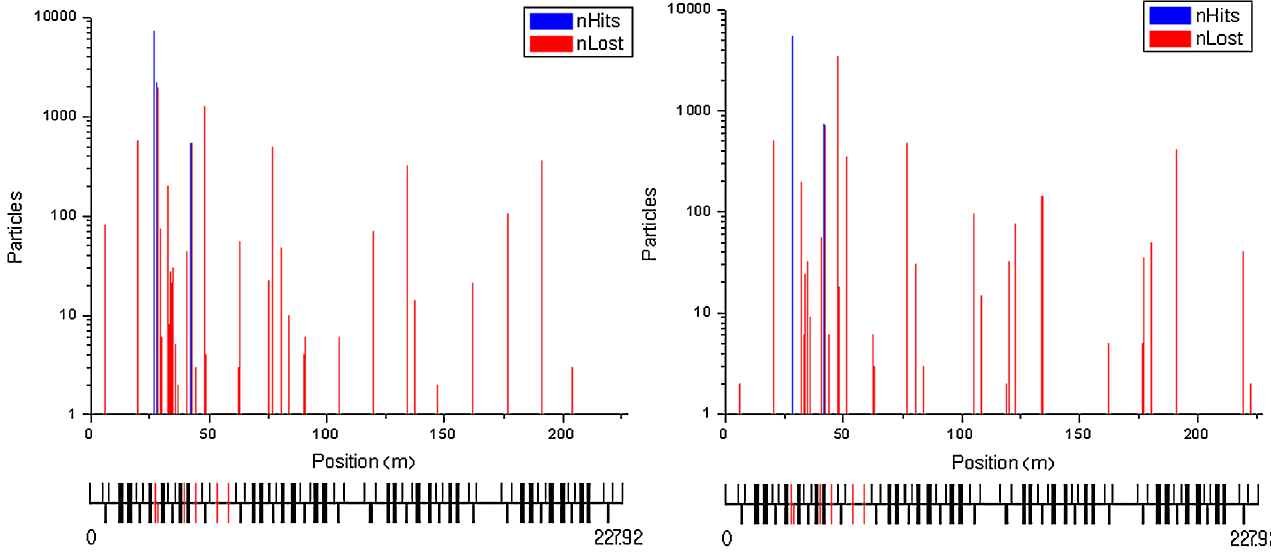
FIG. 8. Lost particles and the corresponding positions in the ring for a correlated beam at 80 MeV. nHits and nLost have the same meaning as in Fig. 4. A total of 10 000 particles are injected. Left: (cid:1) ¼ (cid:1) 1 : 03% ; right: (cid:1) ¼ 1 : 03% .